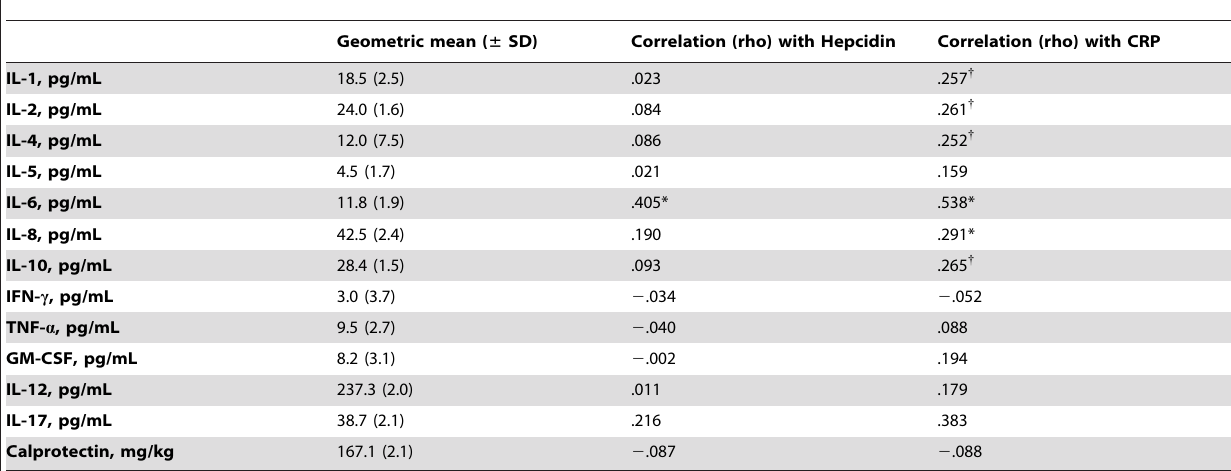
Table 4. Mean levels of cytokines and fecal calprotectin and their correlation with hepcidin and CRP.